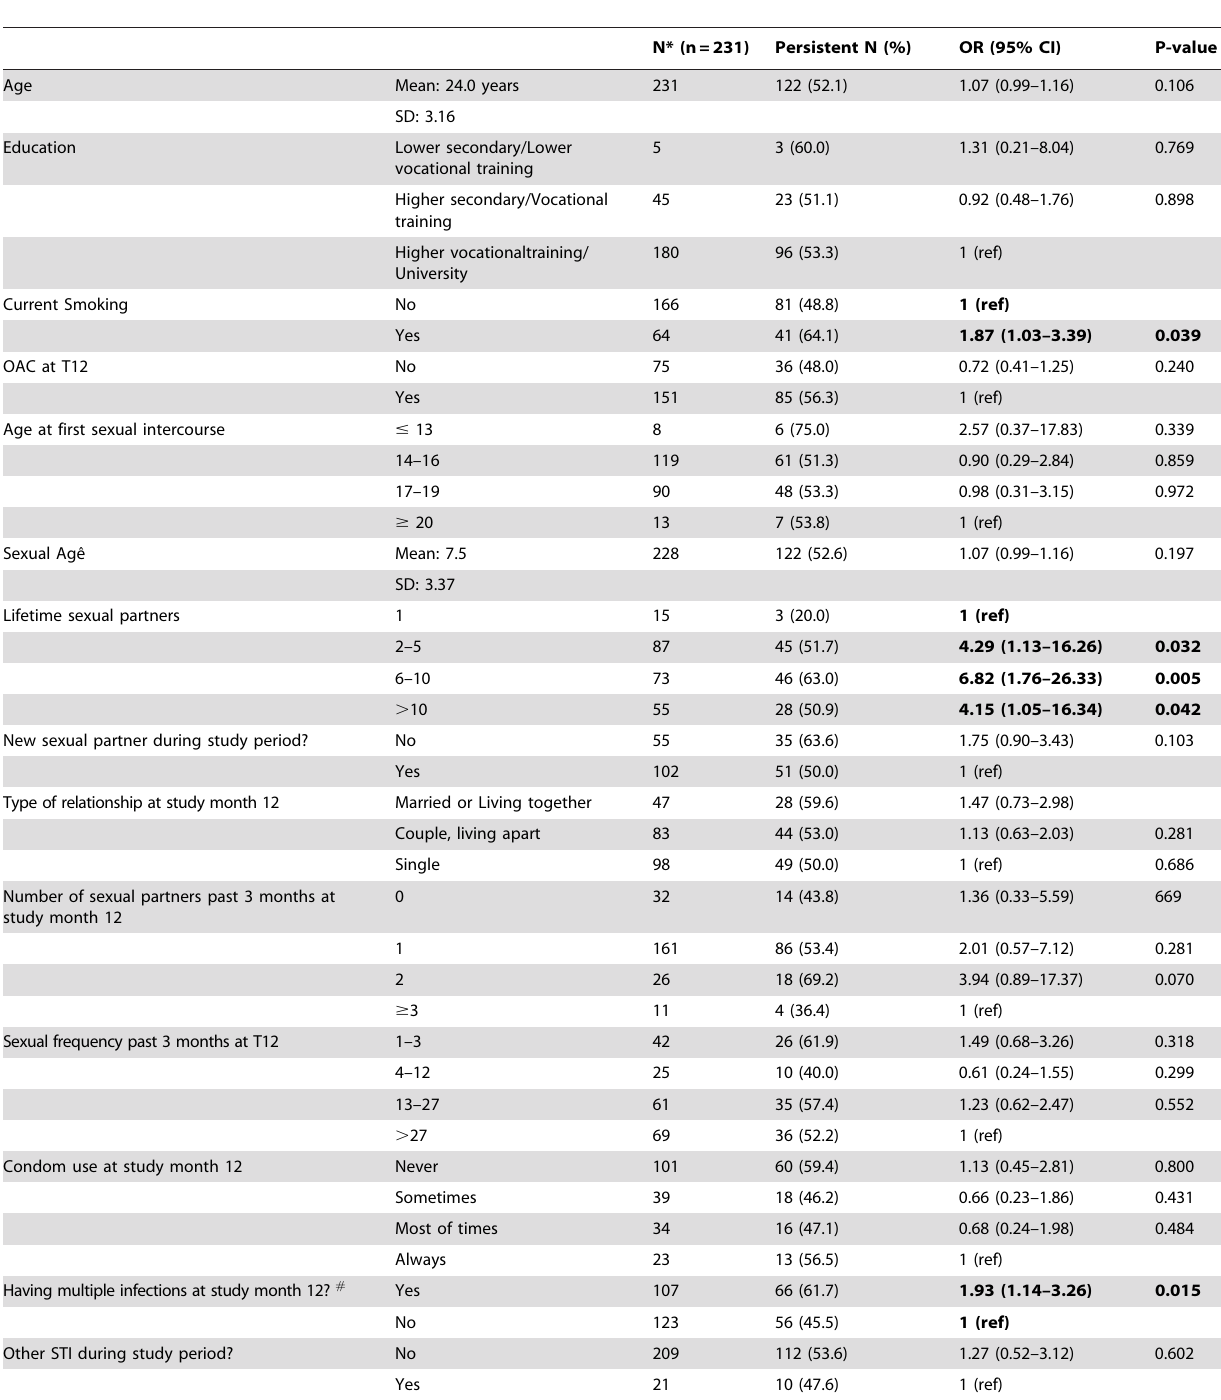
Table 5. Woman’s risk of having a persistent type-specific hr-HPV type in the 2 nd study year.